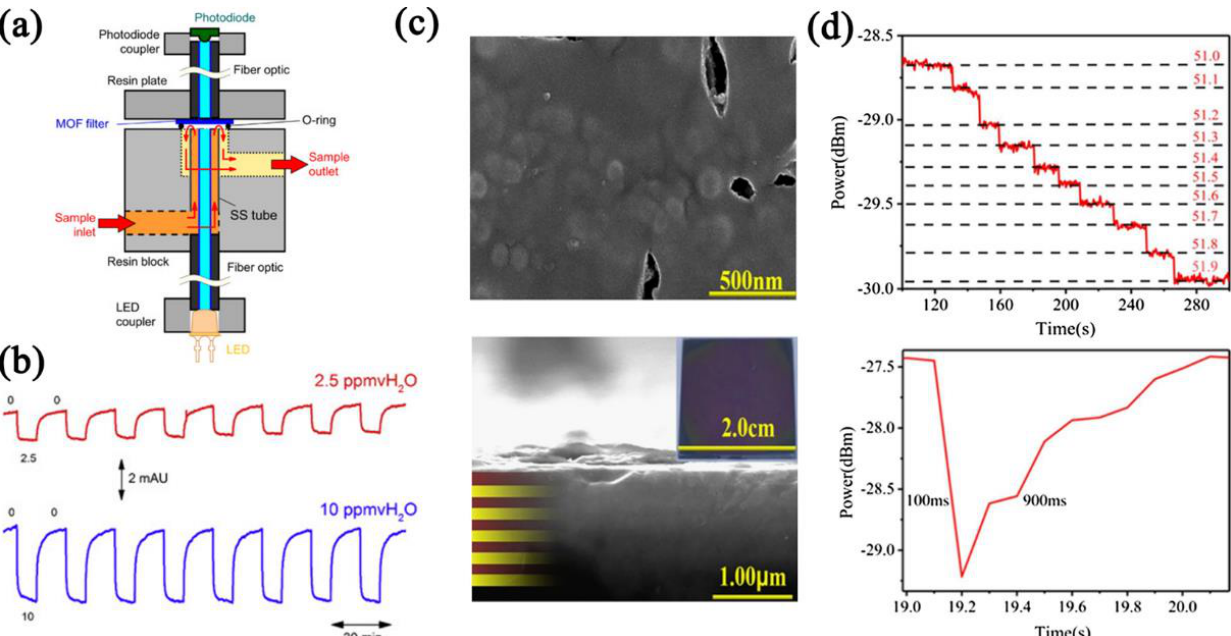
Figure 19. ( a ) Schematic of the fiber − optic humidity − sensing device. ( b ) Cycling curves of Cu − BTC − based fiber − optic humidity sensor in low ppmv levels (0 – 2.5 ppmv and 0 – 10 ppmv). Reproduced with permission from Ref. [148]. Copyright 2015, Elsevier. ( c ) Above sectional and cross − sectional SEM images and optical image of MOF − 801/TiO 2 1DPC. ( d ) Response curve of MOF − 801/TiO 2 1DPC sensor in 0.1% RH change and the response time and recovery time of MOF − 801/TiO 2 1DPC sensor. Reproduced with permission from Ref. [150]. Copyright 2020, Elsevier.